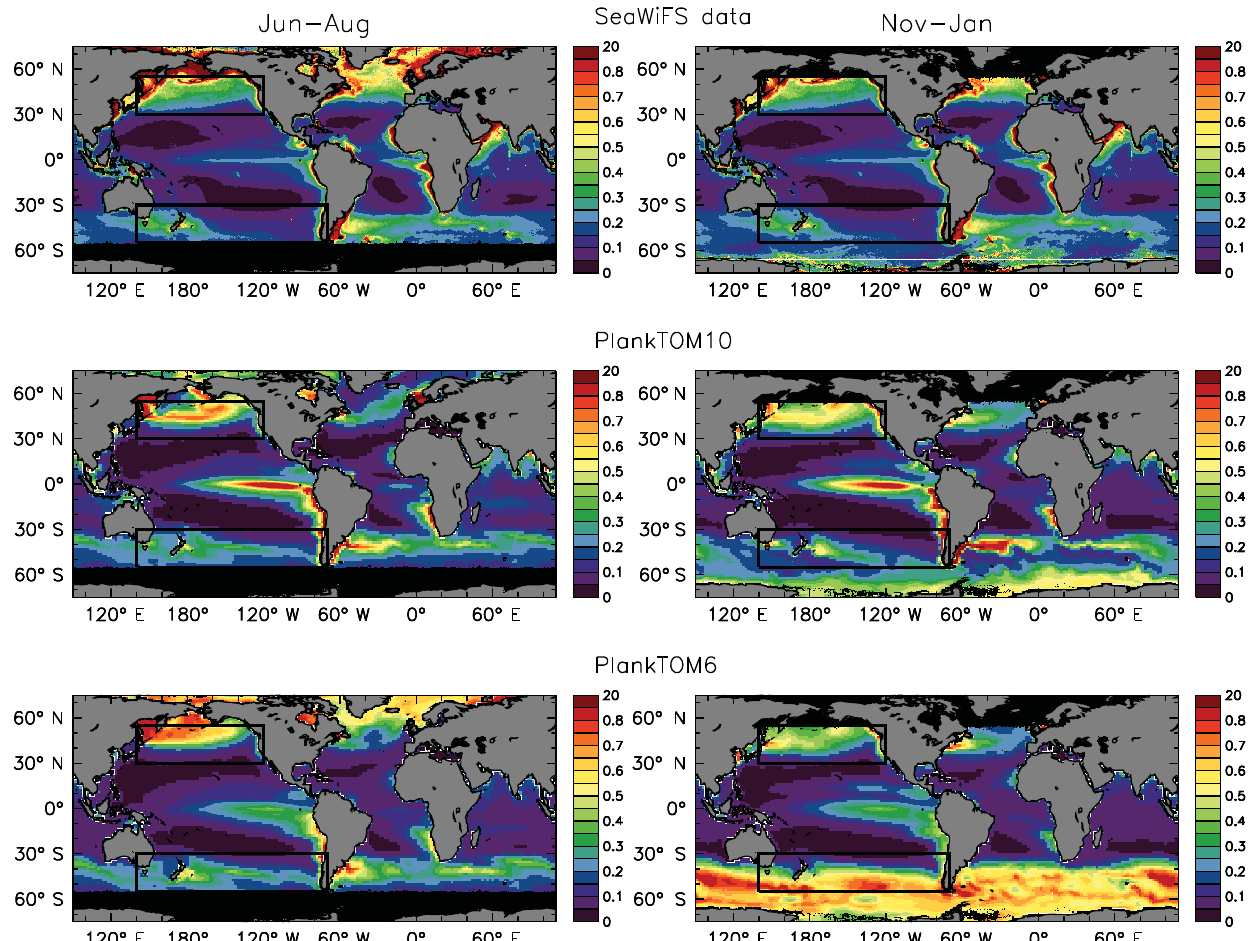
Figure 4. Surface Chl (mgm − 3 ) for (left) Southern Ocean winter (June–August) and (right) Southern Ocean summer (November–January). Data are from (top) SeaWiFS satellite, (middle) PlankTOM10, and (bottom) PlankTOM6. All data sets are averages for 1998–2009. Model results are shown for the top 10m deep surface box. The boxes highlight the regions used in Fig.